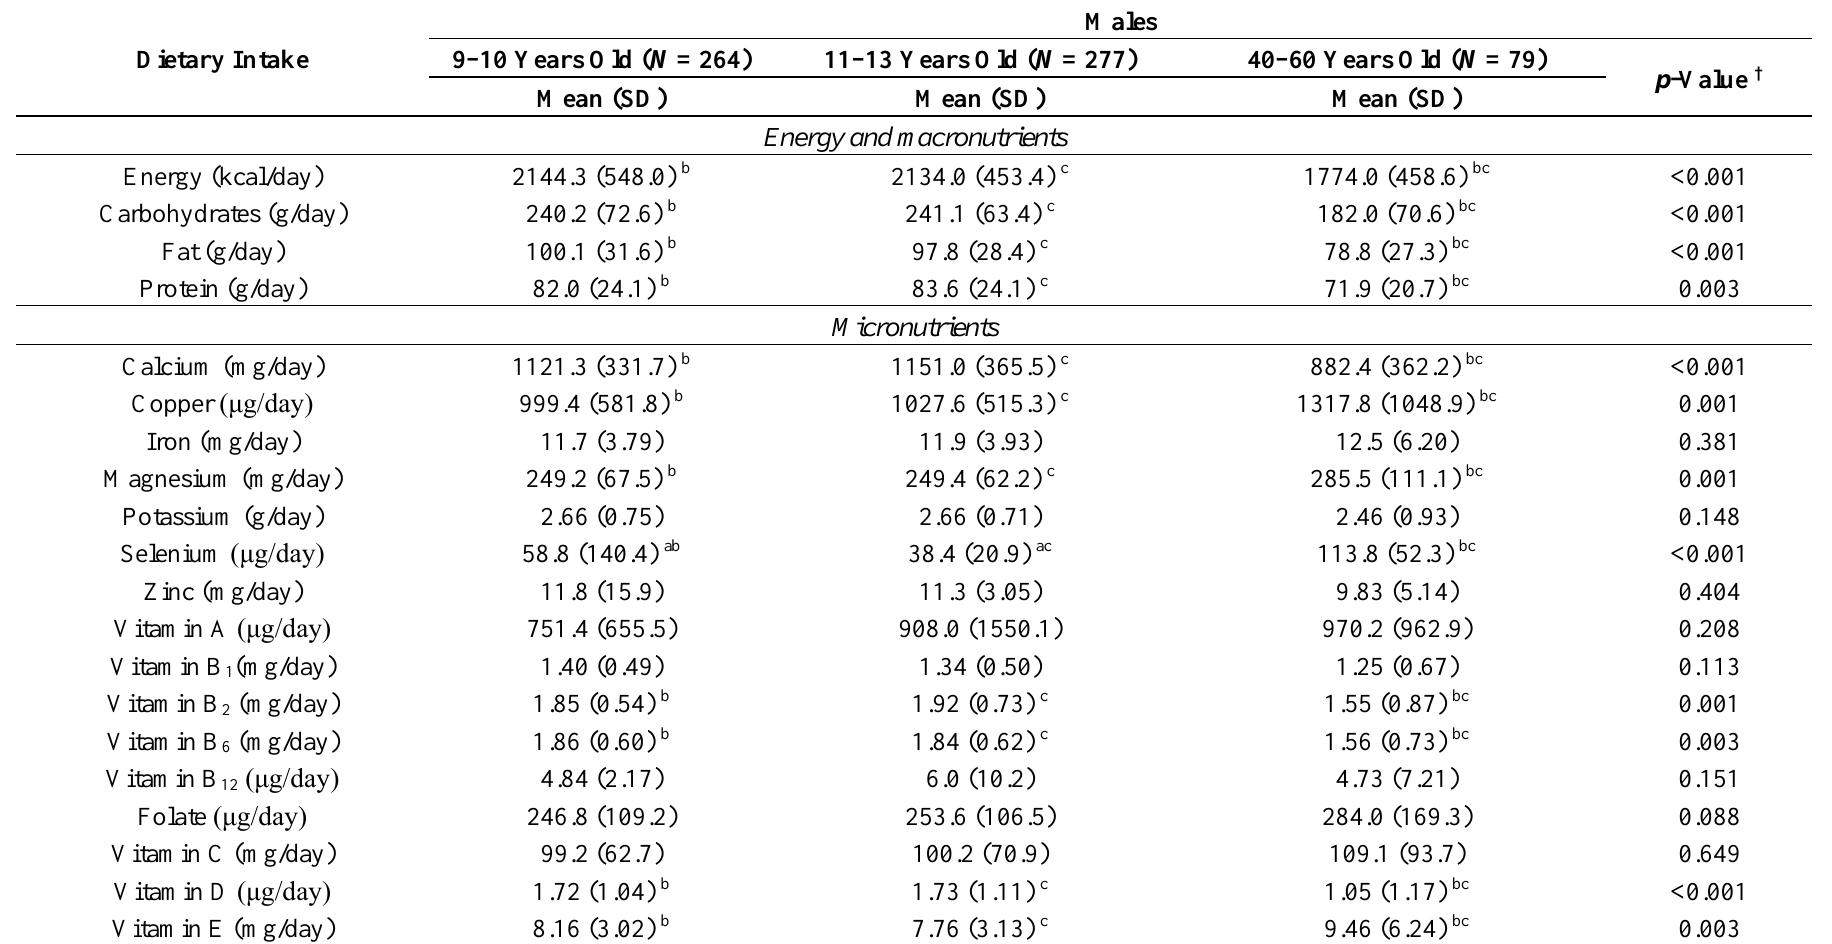
Table 2. Average energy, macronutrient and micronutrient intakes in boys and middle-aged men in Greece presented by age group. Dietary